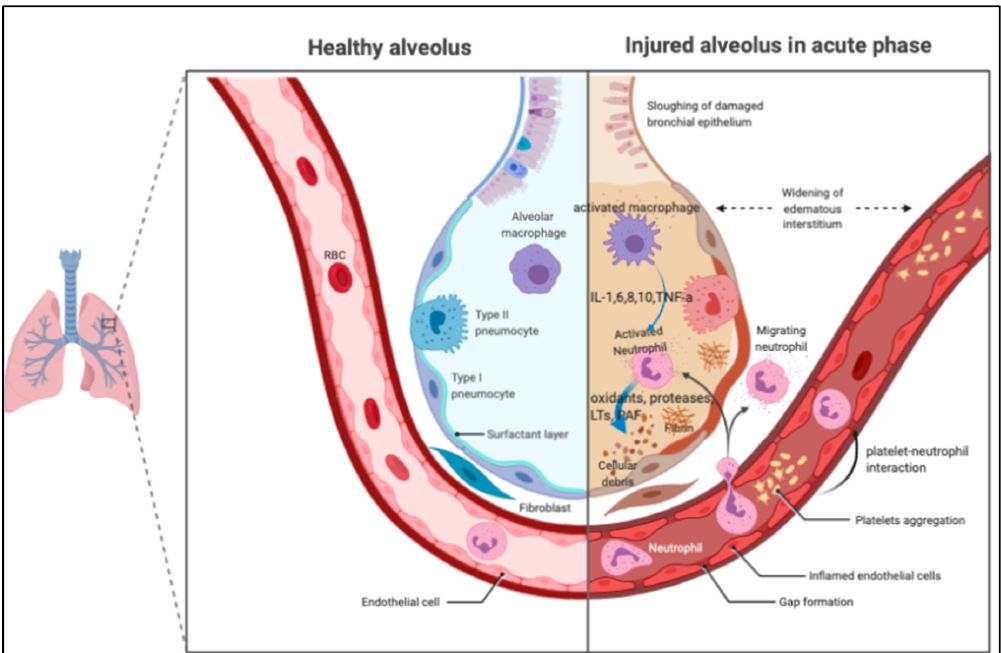
Figure 1. The pathological features of acute respiratory distress syndrome (ARDS) in the acute phase. In the air space, alveolar macrophages secrete cytokines locally to stimulate chemotaxis and activate neutrophils. Neutrophils can release oxidants, proteases, leukotrienes, and other pro-inflammatory molecules, such as platelet-activating factor (PAF). PAF: platelet-activating factor; IL: interleukin; TNF: tumor necrosis factor; LTs: